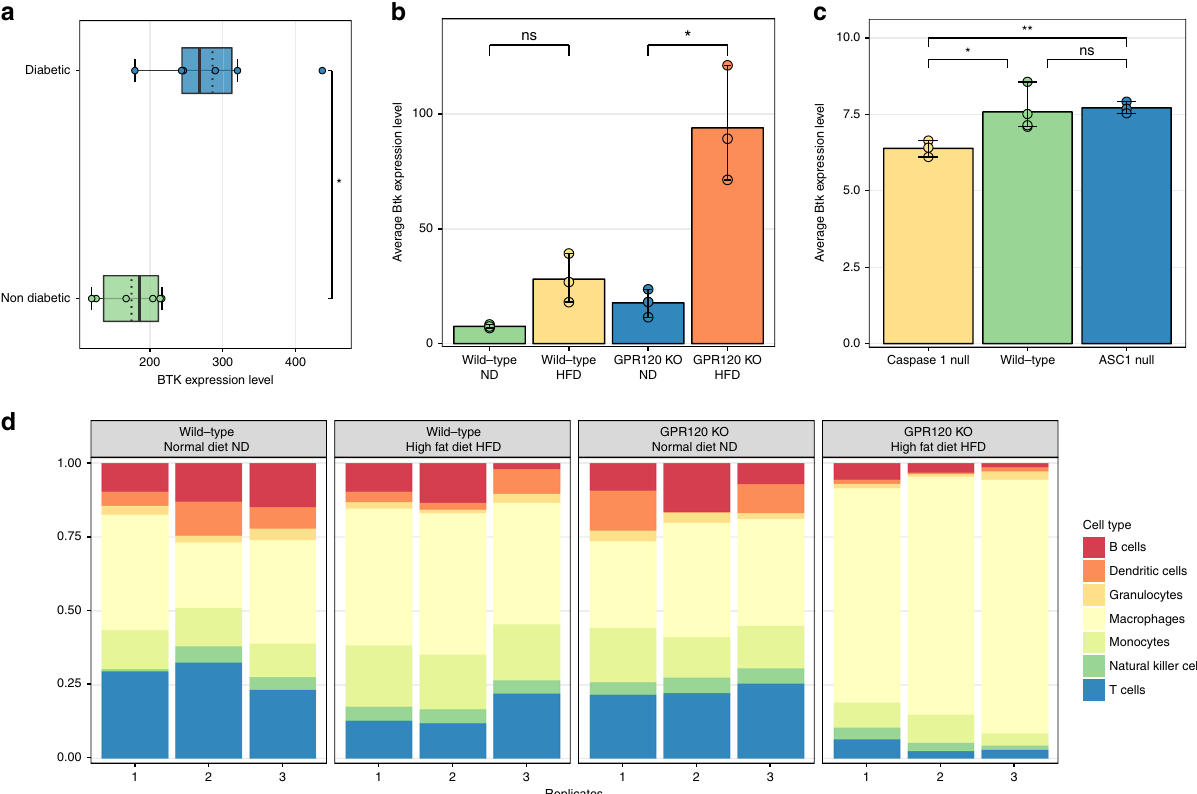
Fig. 7 BTK expression in public datasets. a Boxplots showing BTK gene expression in macrophages of diabetic and non-diabetic subjects. The points represent the single values while the black tick lines indicate the median values and the dotted lines indicate the mean values. b Bar charts showing the gene expression level of Btk in adipose tissue for wild type and GPR120 KO mice fed with normal diet (ND) or high fat diet (HFD). The charts represent the mean of n = 3 replicates. The error bars indicate the min-max interval. c Bar charts showing the gene expression level of Btk in adipose tissue for wild-type, Caspase 1 null and ASC1 null mice. The charts represent the mean of n = 3 replicates for Caspase 1 null and ASC1 null mice and n = 4 for wild type mice. The error bars indicate the min-max interval. d Estimated relative fraction of different immune cells in adipose tissue calculated via Cibersort for wild type and GPR120 KO mice fed with normal diet (ND) or high fat diet (HFD) in adipose tissue. In a-c, statistical signi fi cance is denoted as follows: ns: not signi fi cant ( p -value > 0.05), *:0.01 < p -value < = 0.05, **:0.01 < = p -value < 0.001 (Student ’ s t test). Source data are provided as a Source Data fi